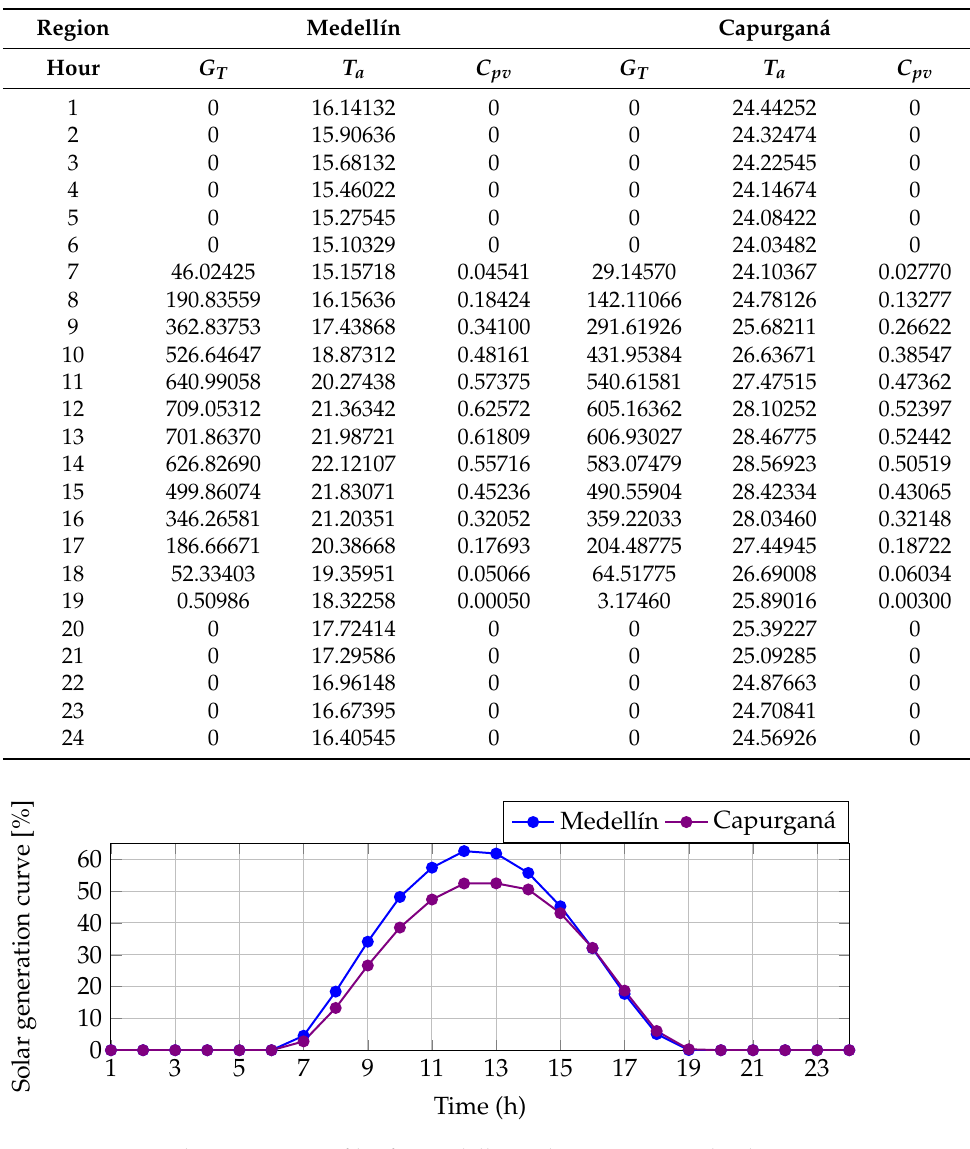
Table 2. Solar radiation data (W/m 2 ), ambient temperature ( ◦ C), and behavior (p.u.) for an average day in the regions under study.